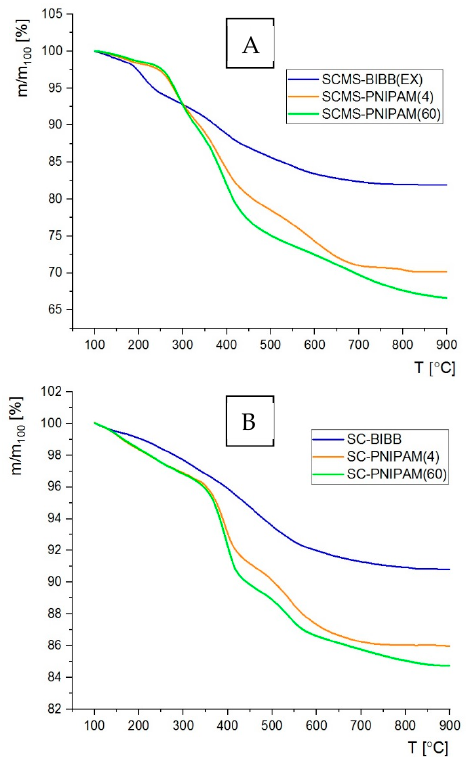
Figure 2. Thermogravimetric analyses of the samples based on (A) SCMS, and (B) SC particles.